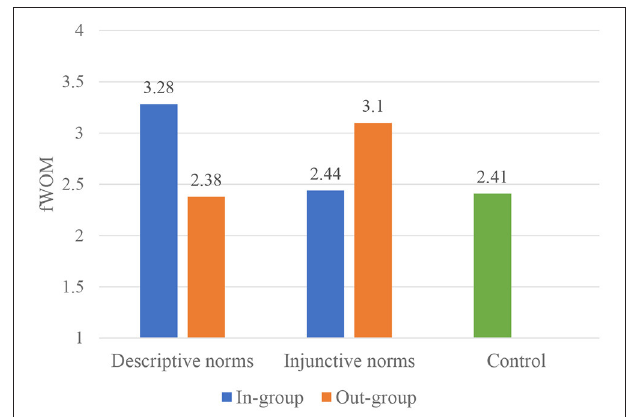
FIGURE 1 | The interaction of social group and norms type on fWOM (Study